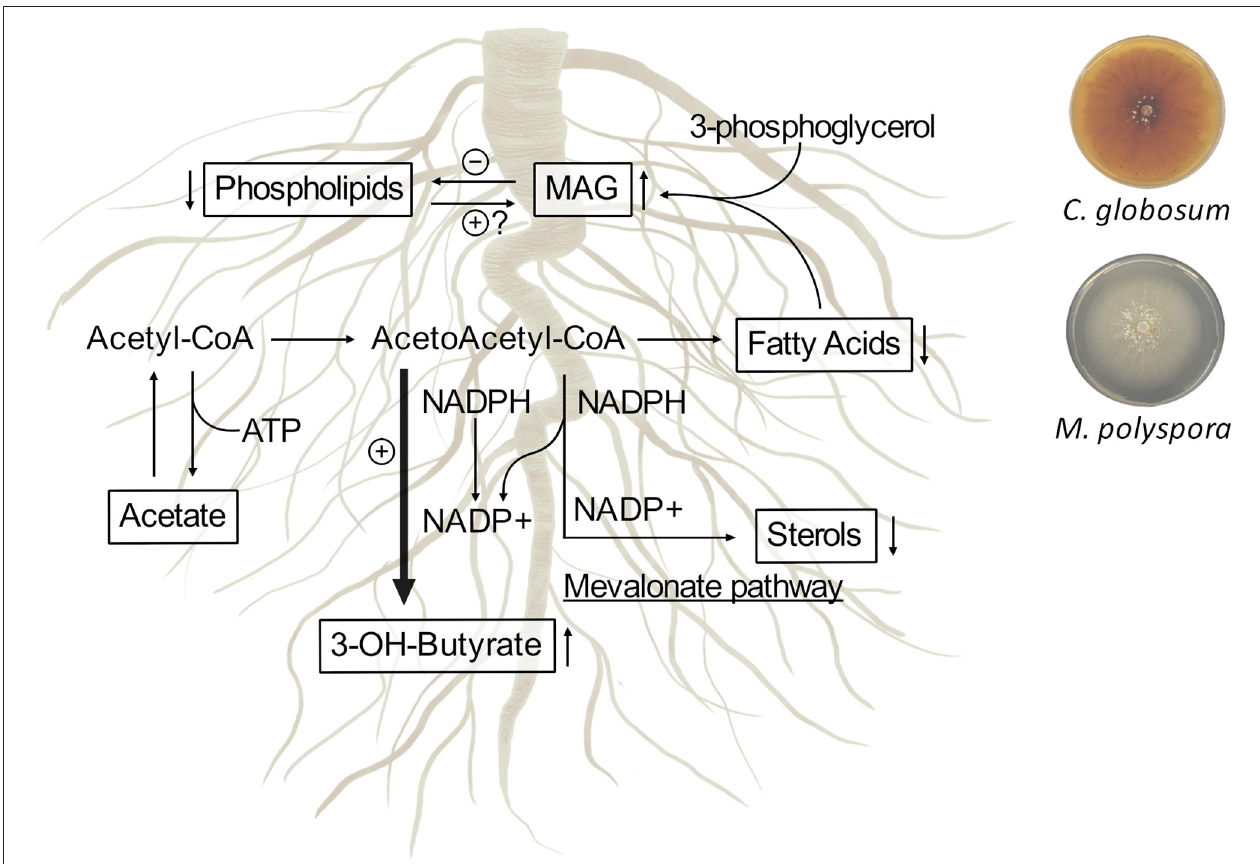
FIGURE 8 | Metabolic network involving 3-OH-butyrate, phospholipids, sterols, and fatty acids occur in C. intybus roots after treatment with C. globosum (205) and M. polyspora (503) culture filtrates. The identified metabolites and their variations are reported in